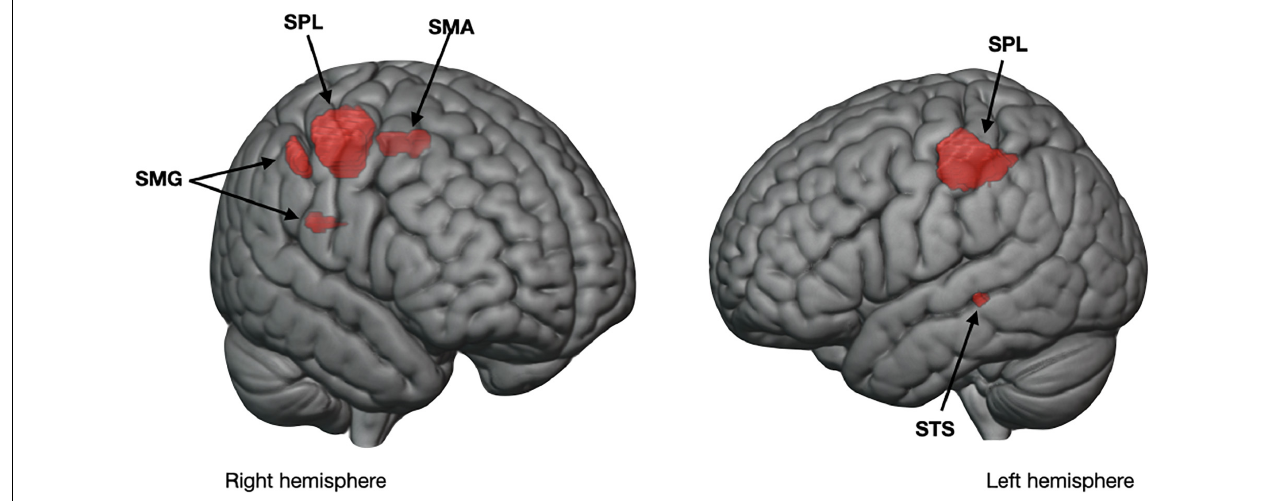
FIGURE 4 | Overlapping neural areas of purchase intention. An overlay of significant clusters obtained from mass univariate analysis showing a main effect of purchase intention and from multivariate pattern analysis demonstrating classification accuracy above the chance level (50%). SPL, superior parietal lobule; SMA, supplementary motor area; SMG, supramarginal gyrus; STS, superior temporal